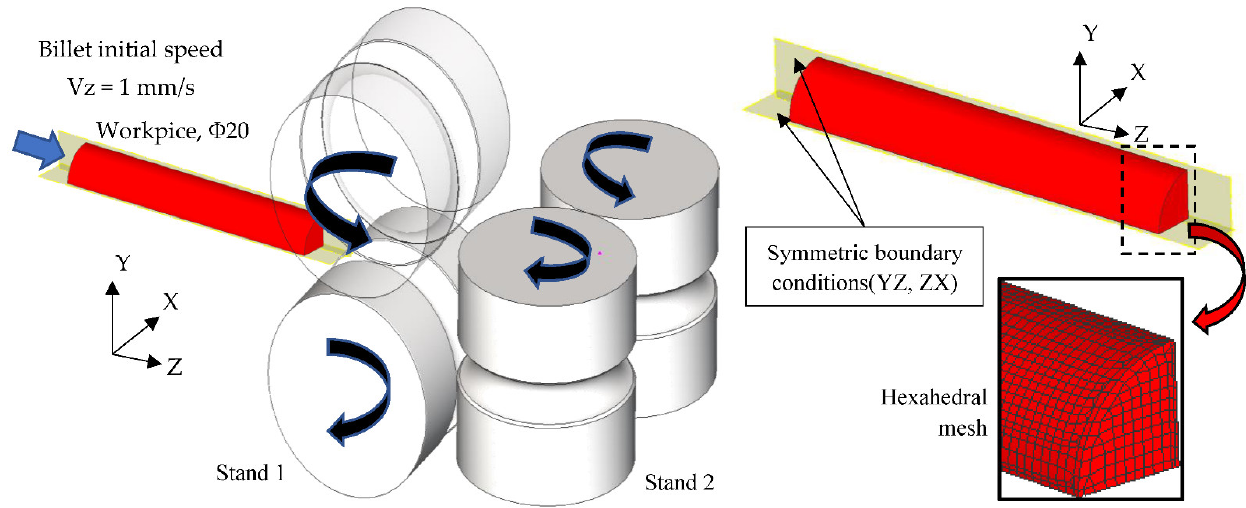
Figure 3. FEM model of the wire billet and the boundary conditions. Table 1. CAE simulation parameters.